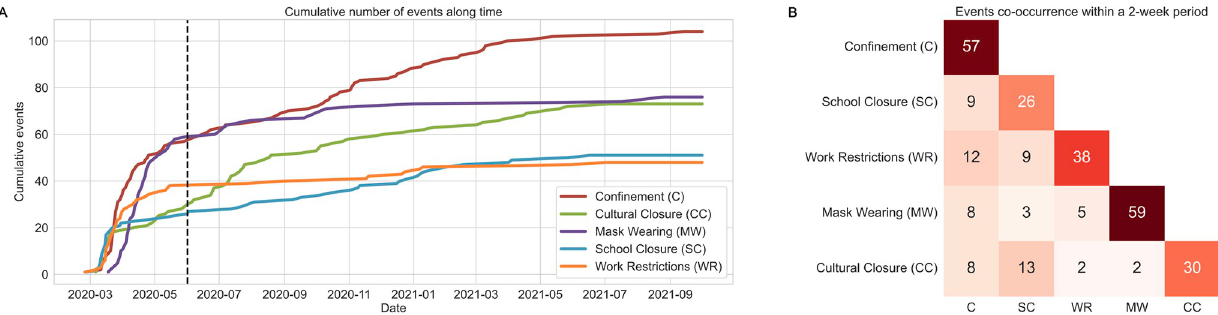
Fig 3. Distribution of NPIs and frequency of their co-existence. (A) Cumulative number of events over time. An event is defined as the day when an intervention was enacted in a country, considering that this NPI was not active the day before. Until June 1 st 2020 (dashed vertical line), 60% of all events had already happened. (B) Co-occurrence matrix of events in the limited period until June 1 st 2020. The diagonal values represent the number of events. Cell values indicate the sum of times that NPI i (x-axis) and NPI j (y-axis) were enacted together within a period of 2 weeks in the same country or US state.